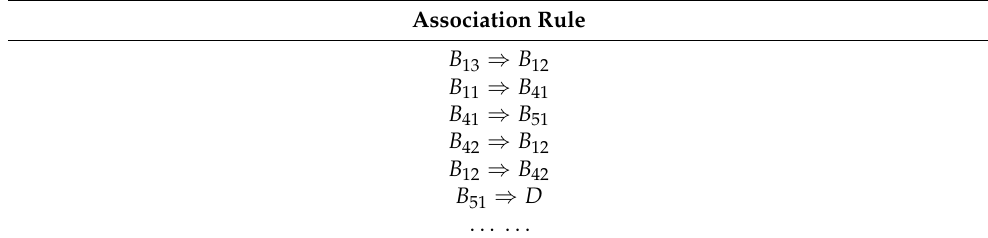
Table 3. Association rules of factors.